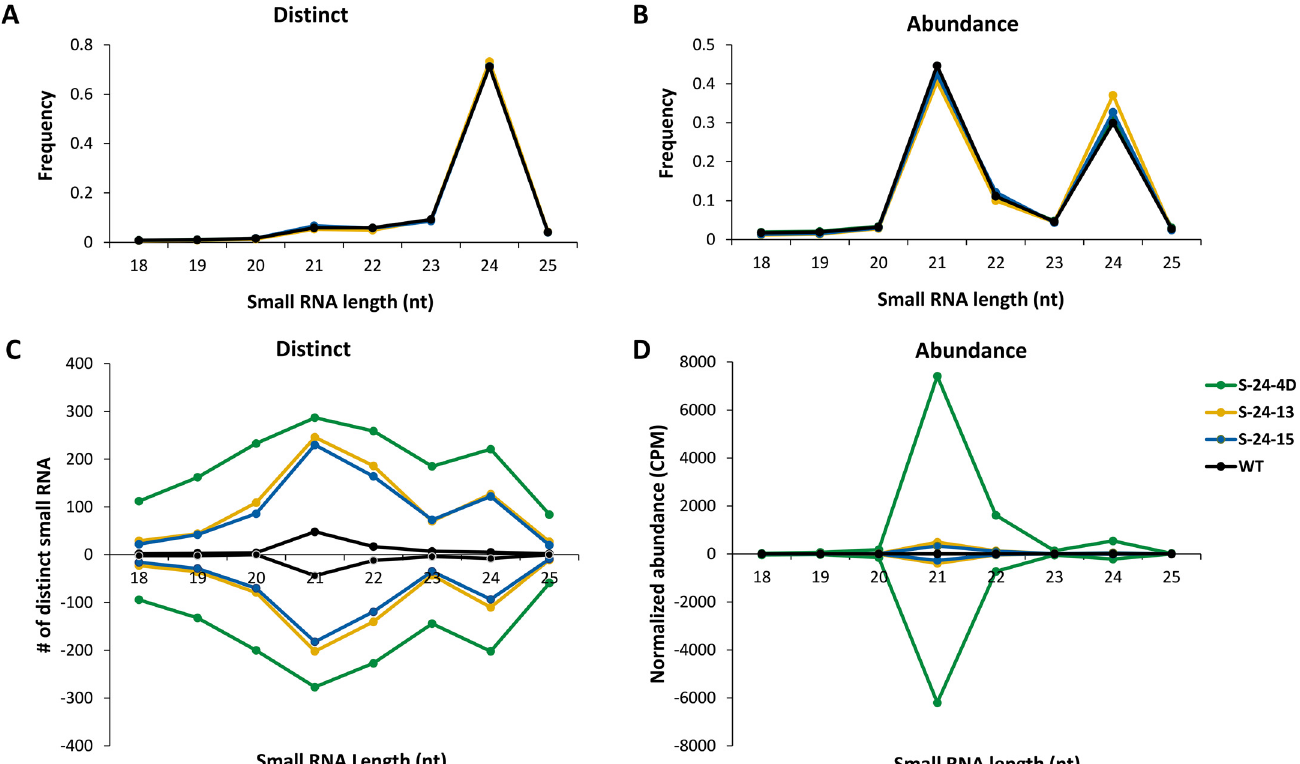
Fig 4. Small RNA size distribution. The size of small RNA from each sample was plotted versus frequency (0.0 – 1.0) among distinct sequences (A) or total sequences (B) to eliminate the bias of different sequencing depth. (C) and (D) Size profiles of the 318-bp IR small RNAs for distinct sequences and total sequences, respectively. Data are average of three